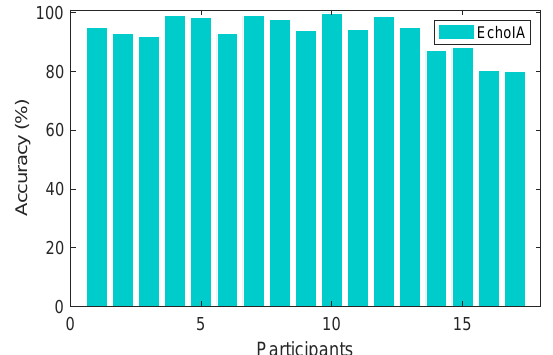
Figure 4. The accuracy for each